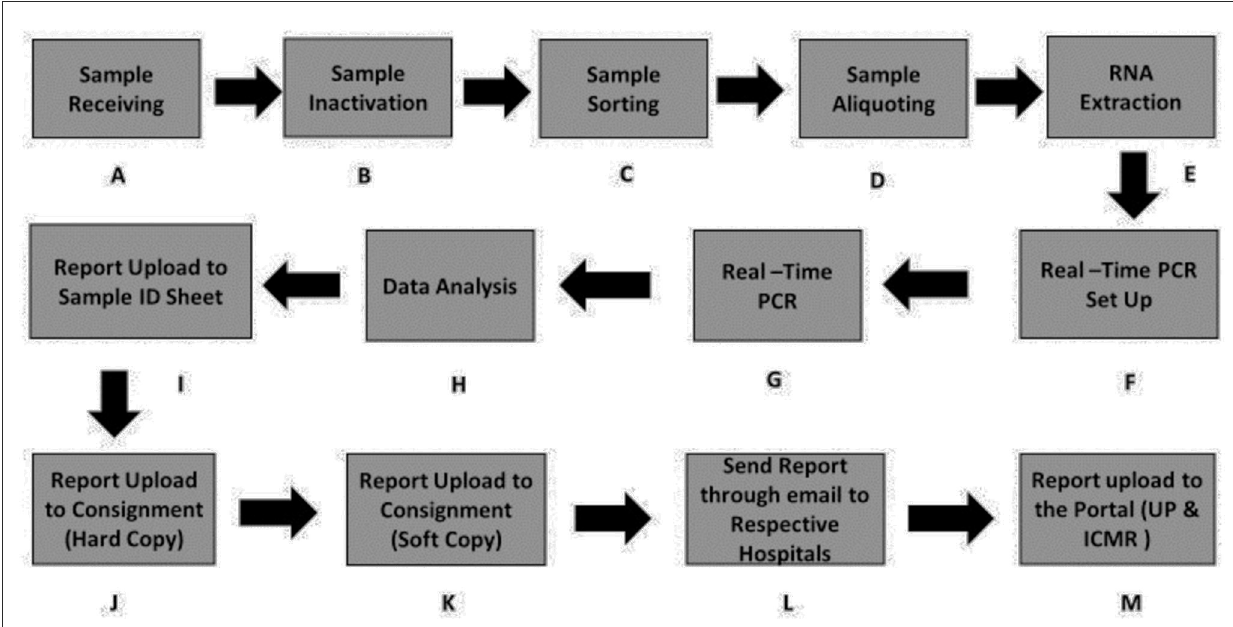
FIGURE3 Workflow of sample processing from the sample receiving to reporting on the data portal. (A) Sample receiving. (B) Sample inactivation. (C) Sample sorting. (D) Sample aliquoting. (E) RNA extraction. (F) Real-time PCR Set UP. (G) Real-time PCR. (H) Data analysis/Data interpretation. (I–M) Steps to data upload on the